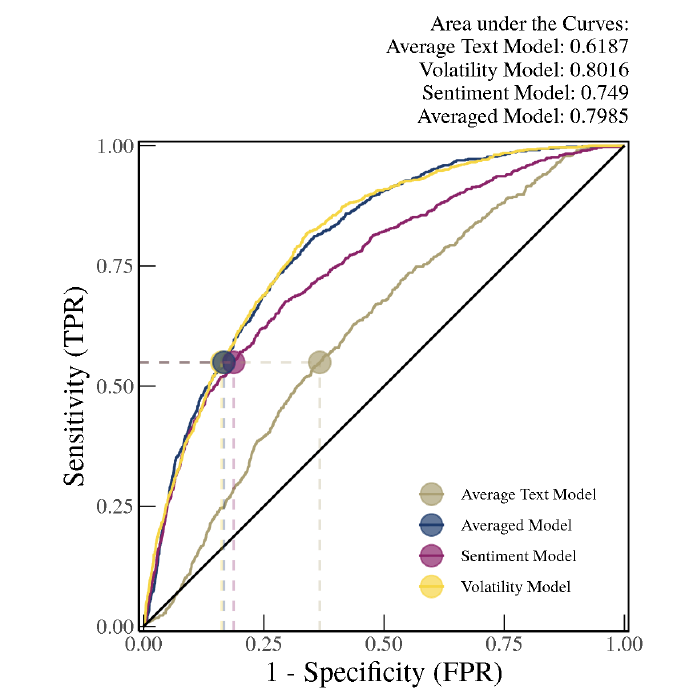
Figure 15. Results for LV Banking Crises on RDNF Text . Note: This figure shows the ROC curves for our out-of-sample period (2005-2017) for models trained on the period 1996–2004 using RDNF text based on Laeven and Valencia (2013) banking crises. The results show that the Volatility Model performs best (0.8016), followed by the Averaged Model, Sentiment Model, and Average Text Model.